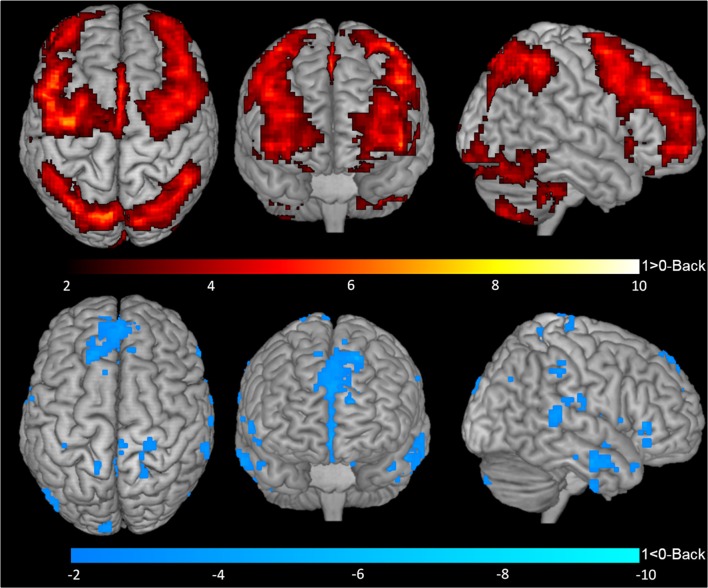
Blood oxygen level dependent (BOLD) response during 1-Back performance. Representation of 1-Back performance functional activation (1-Back > 0-Back—top) and deactivation (1-Back < 0-Back—bottom) in axial (left), coronal (middle) and sagittal (right) views. Hotter and colder colors represent respectively increased activation and deactivation.